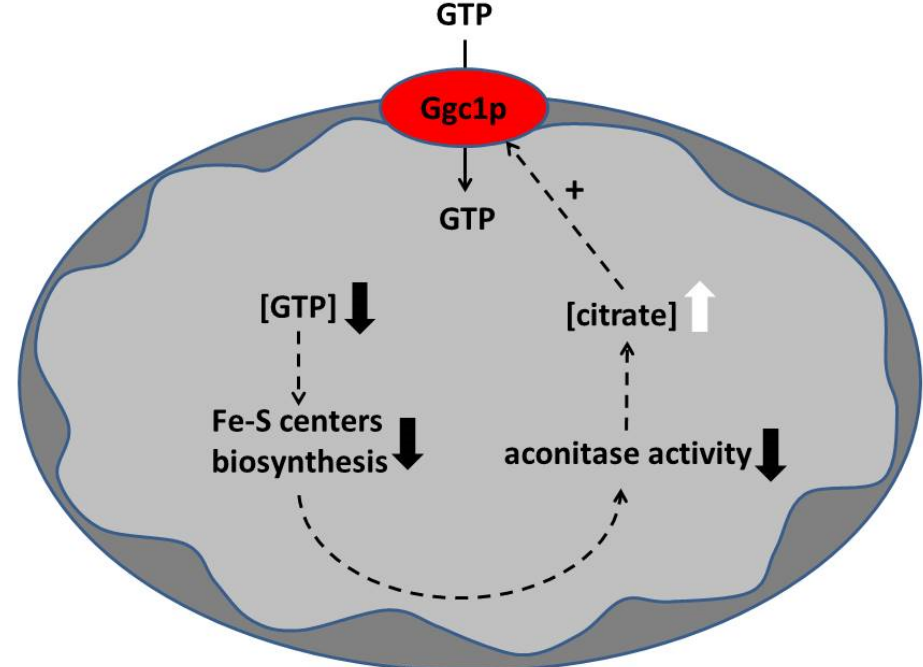
Figure 11. Schematic diagram representing a model linking the level of citrate in the mitochondrial matrix to the GTP level in the same organelles. Squared brackets indicate the concentration of citrate or GTP; downward black arrows indicate a decrease, and upward white arrows indicate an increase. The scheme is depicted to show the stimulating role of citrate in GTP import via Ggc1p (CIGU). However, the same model (with the arrows inverted) can describe the negative effect of an increased intramitochondrial GTP level on the intramitochondrial citrate level leading to reduction in the citrate-induced GTP uptake via Ggc1p (CIGU).